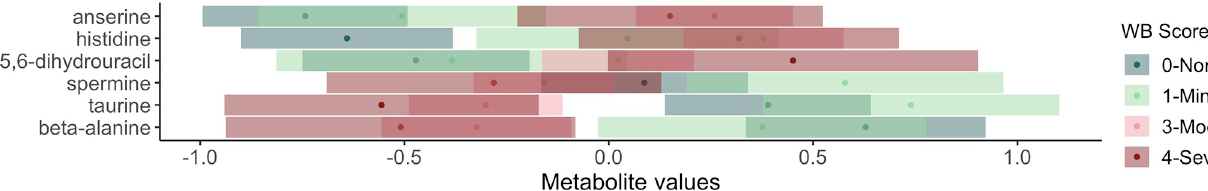
Fig 4. Association of wooden breast score with beta-alanine and taurine metabolism in plasma of male broiler chickens. Results of post-hoc analysis of metabolite values by wooden breast score are shown with estimated marginal means (dots) and confidence intervals (bars). Overlapping confidence intervals indicate that there is no significant difference between the two scores. To improve visualization, metabolites are listed in order of the adjusted means for a wooden breast score of 0-Normal.